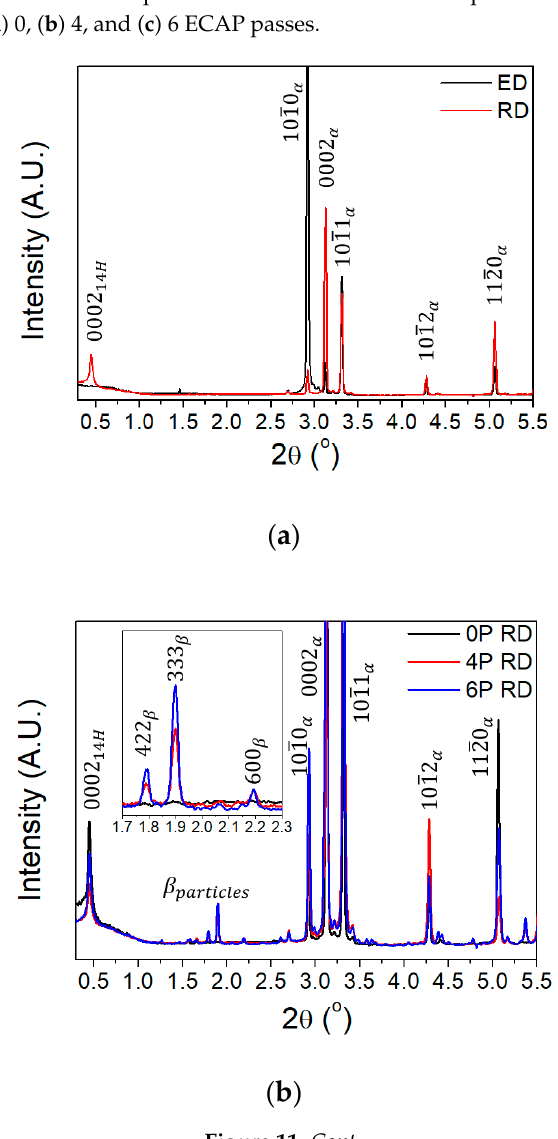
Figure 11. ( a ) Axial and radial diffraction patterns as a function of 2 θ obtained by integration of the Debye-Scherrer diffraction rings for the as-extruded alloy. ( b ) Radial diffraction patterns as a function of 2 θ obtained by integration of the Debye-Scherrer diffraction rings for the as-extruded alloy and after ECAP processing. ( c ) Axial diffraction patterns as a function of 2 θ obtained by integration of the Debye-Scherrer diffraction rings for the as-extruded alloy and after ECAP processing aged at 200 °C for 24 h. The influence of the ECAP processing and the thermal treatment of aging on the mechanical properties has been evaluated through tensile tests (Figure 12a). The mechanical strength increases